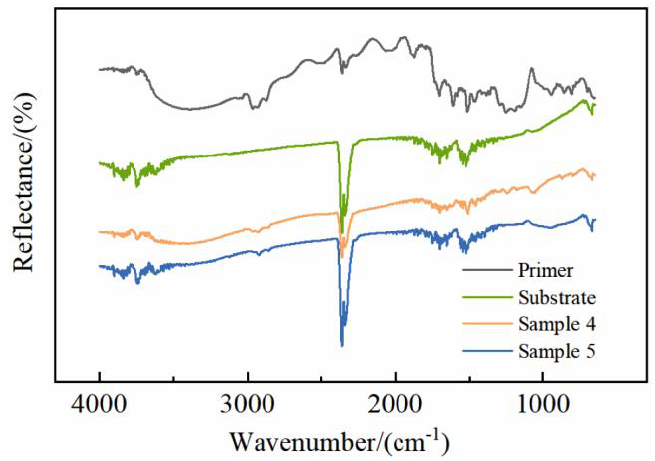
Figure 7. FTIR spectroscopy of primer, substrate, and laser-cleaned sample 4 and sample 5.